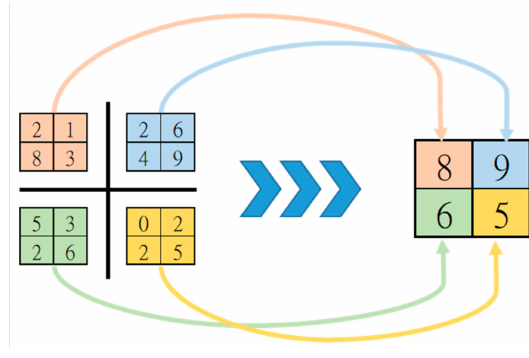
Figure 4. Max pooling.